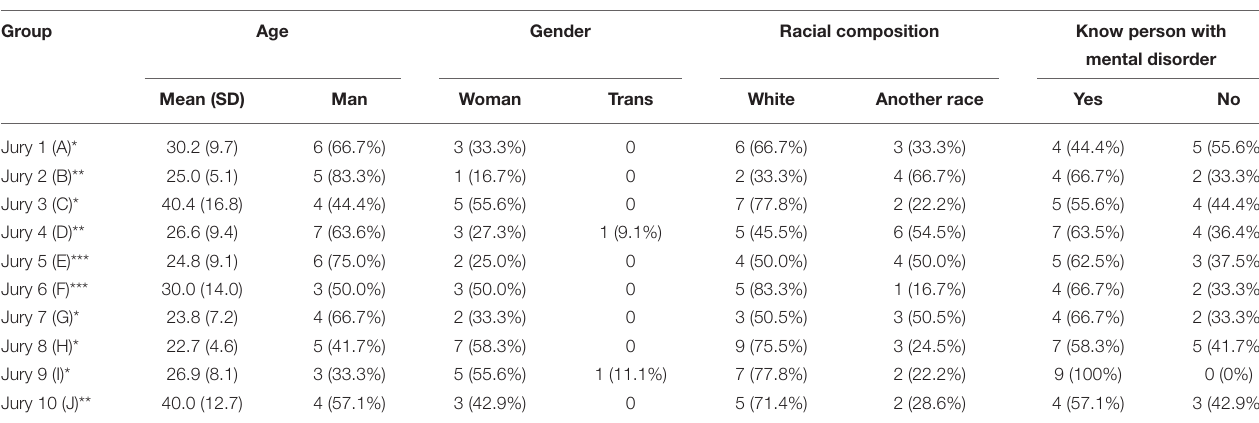
mental disorder